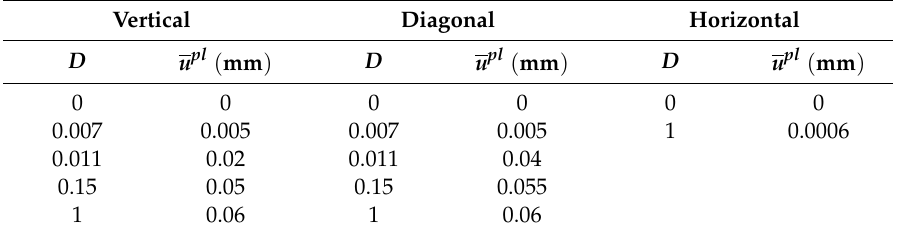
Table 6. Numerically determined damage evolution parameters for EBM Ti-6Al-4V specimens built in vertical, diagonal and horizontal direction. Vertical Diagonal Horizontal